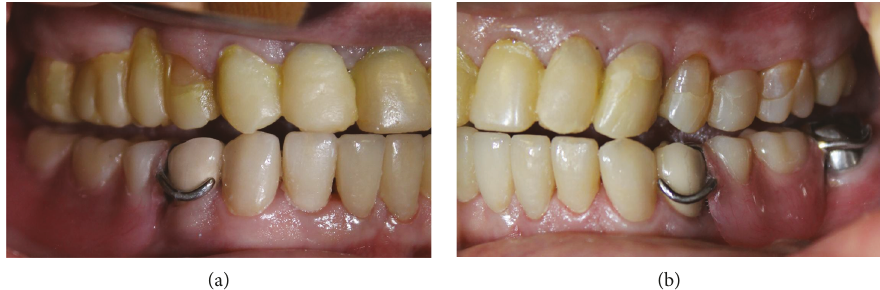
Figure 5: Establishment of mutually protected occlusion after mandibular restoration delivery: (a) right side and (b) left side.